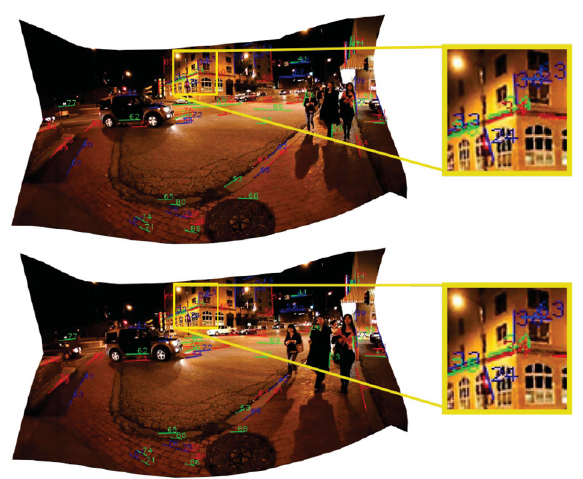
Fig. 4 Line structure and matching between two successive frames. Corresponding lines have the same indices.